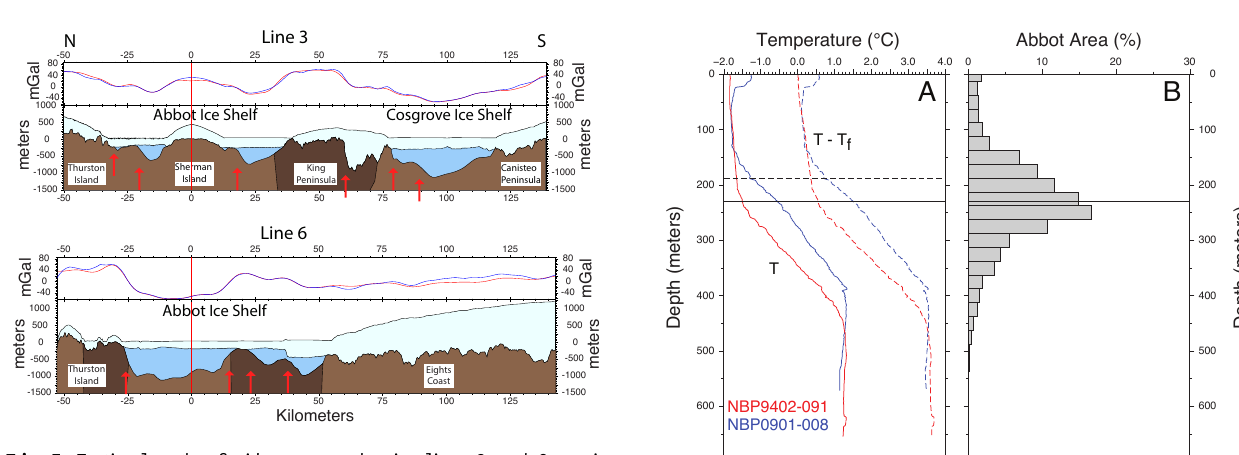
Fig. 5. Entire length of airborne geophysics lines 3 and 6, as in Fig. 3, with line locations shown in Fig. 2. Red arrows show the location of faults mapped in Fig. 4. Note that actual faults will be steeper than shown here because of the filter applied to the gravity data.